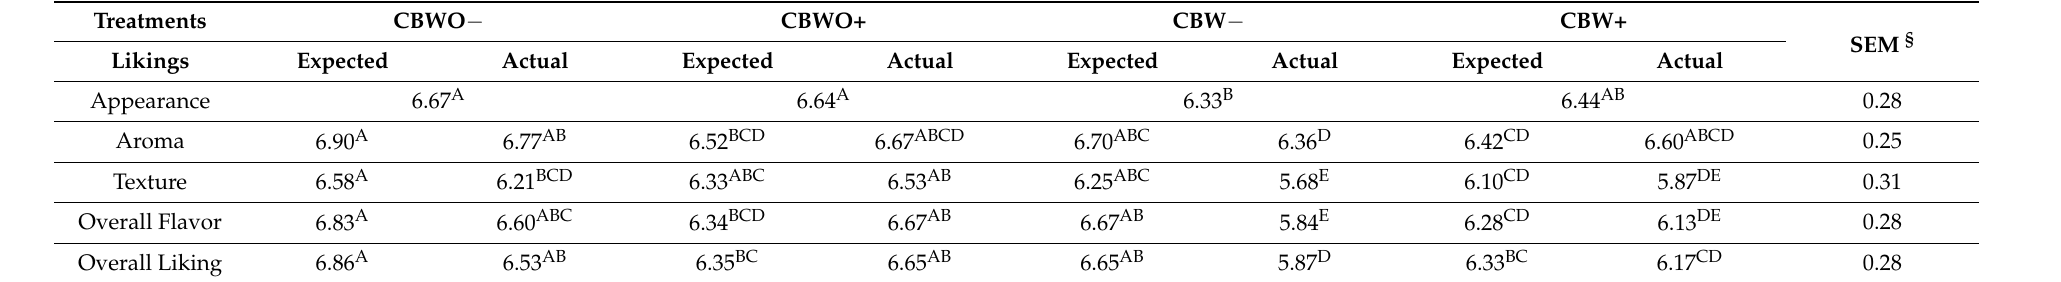
Table 2. Expected and actual sensory acceptability † of treatments ‡